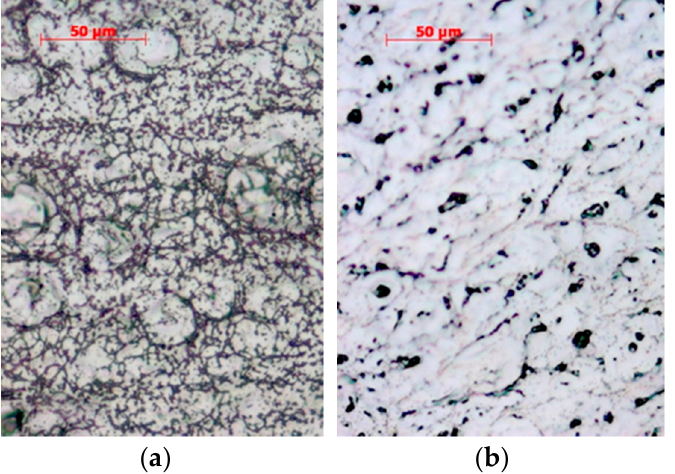
Figure 22. Structure of the surface of an aluminum plate alloyed with a Ni 77 Cr 23 alloy: ( a ) after exposure to the first pulse of the electron beam; ( b ) after irradiation with five pulses.